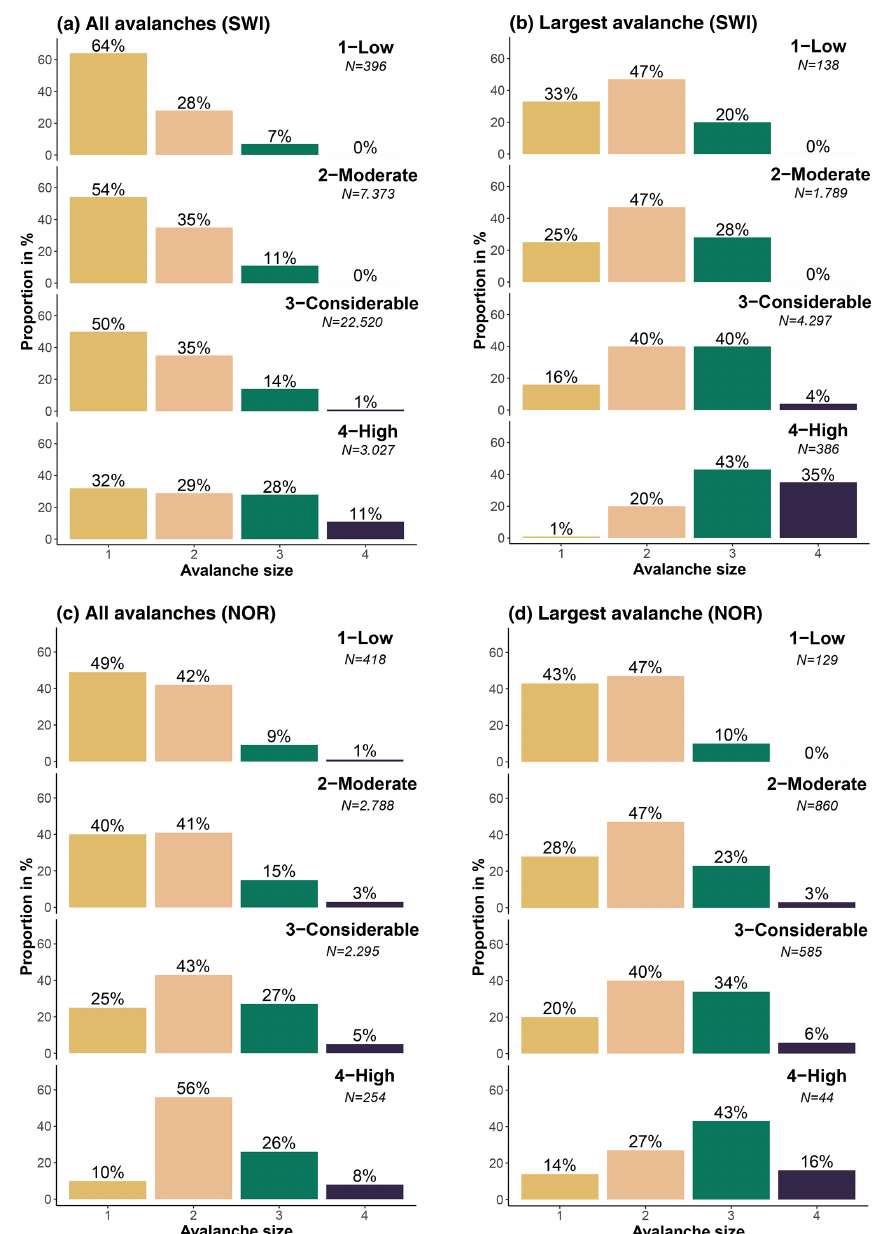
Figure 5. Size distribution of dry-snow avalanches, which released naturally or were human-triggered for danger levels 1-Low to 4-High, showing all avalanches (a, c) and the largest reported avalanche per day and warning region (b, d) in Switzerland (SWI; a, b ) and Norway (NOR; c, d